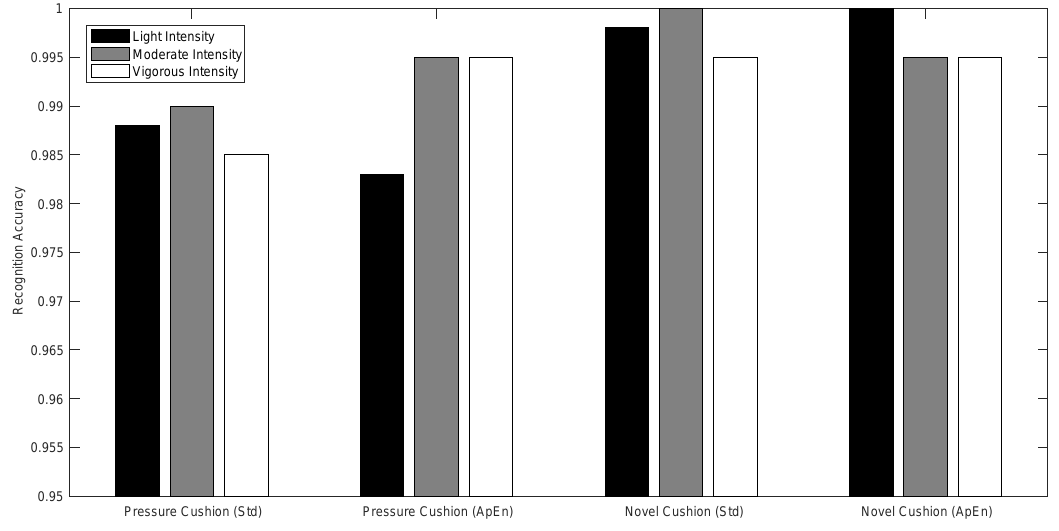
Figure 8. Activity level recognition for different